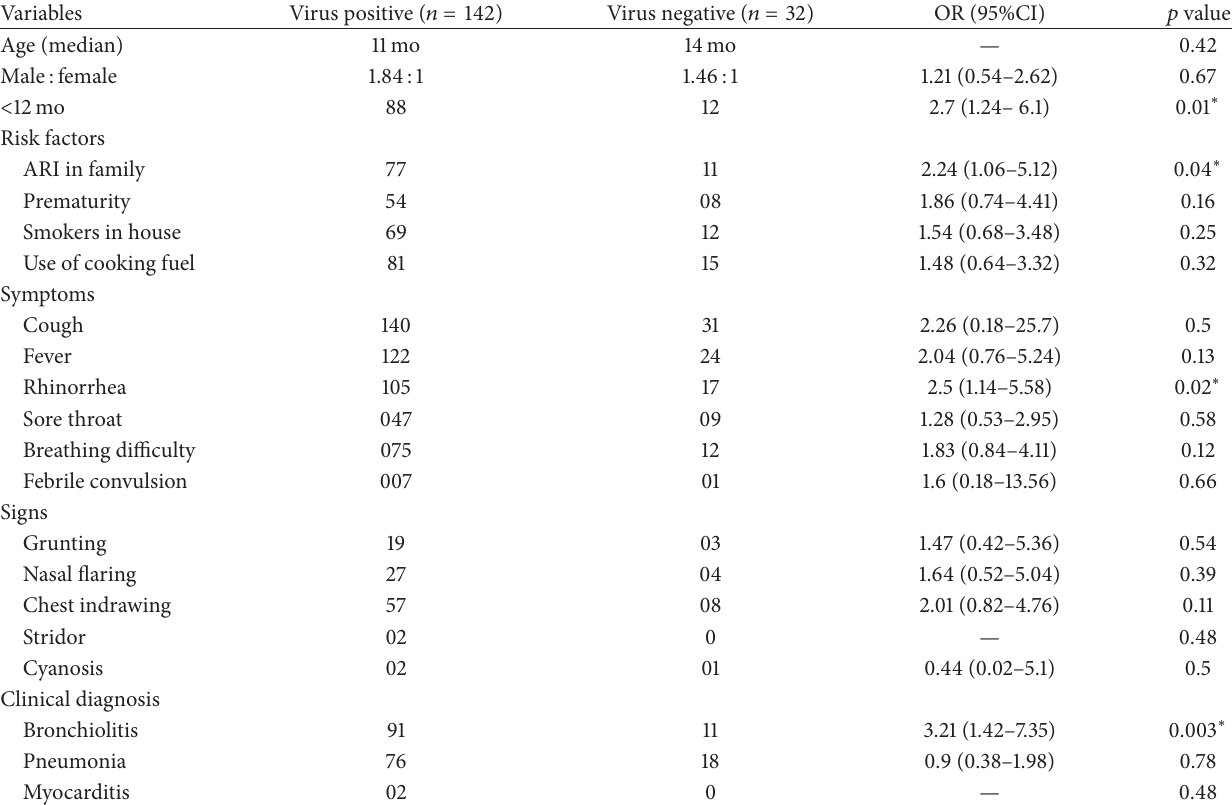
Table 3: Clinical and demographic profile of patients with ALRI as per virus isolation